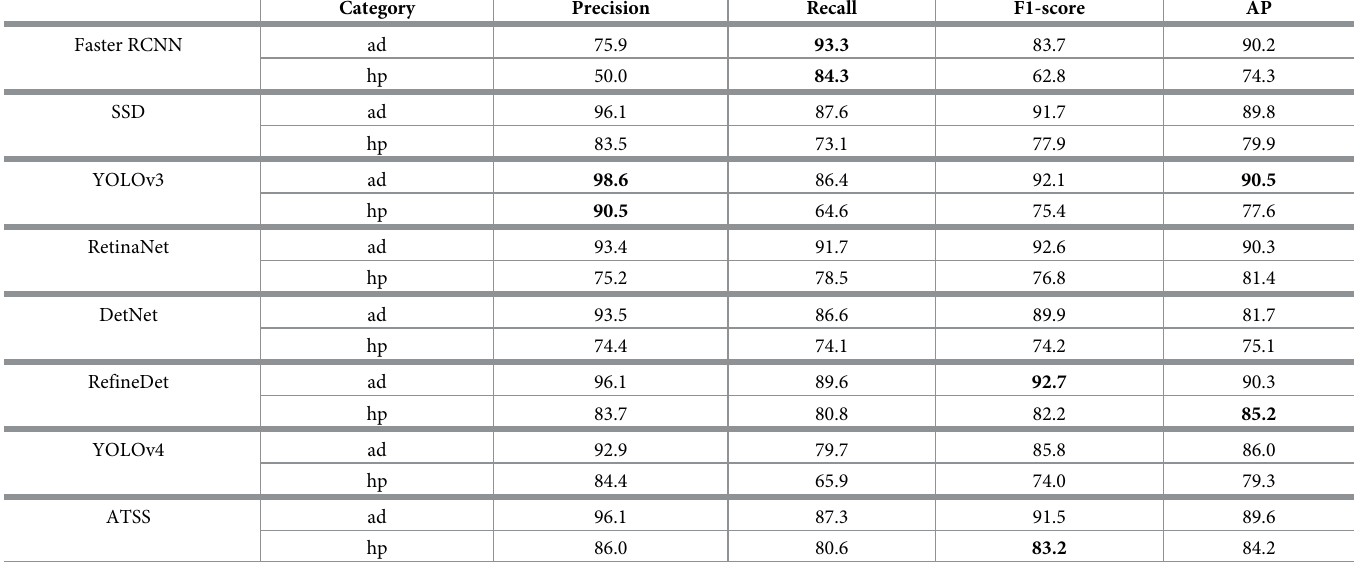
Table 6. Frame-based one-class polyp detection results for each class.